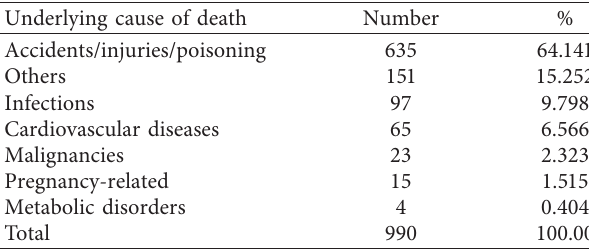
Table 1: Frequencies of underlying causes of death in the